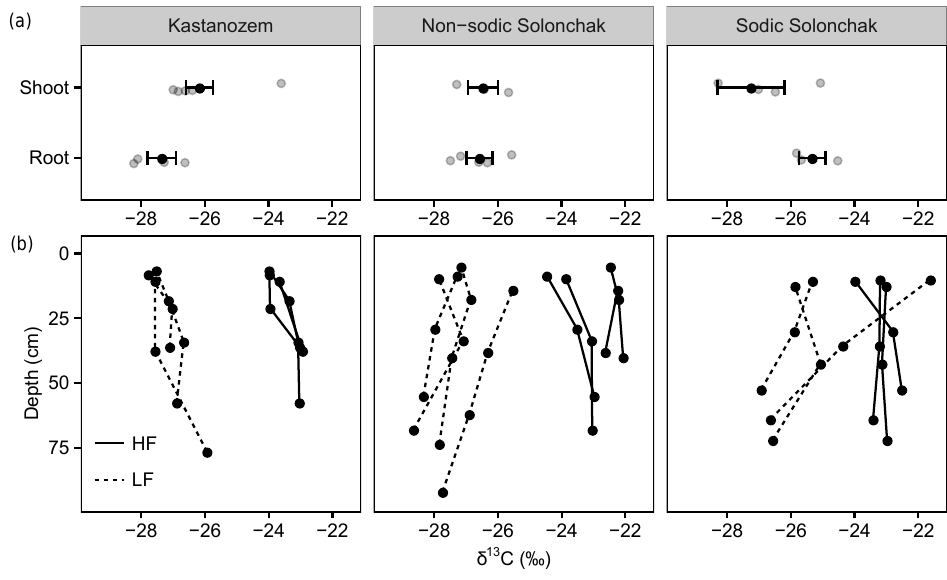
Figure 3. The δ 13 C ratios of (a) plant components and of (b) OM present in the light fraction (LF) and the heavy fraction (HF) as a function of soil depth (b) for three soil types. Gray dots in the upper three panels show individual measurements, while the black dots show the arithmetic means ± standard error of the mean. In (b) , the three and four replicates per soil type are